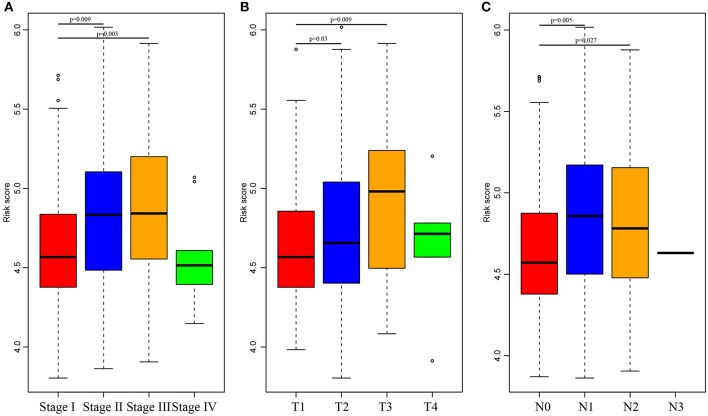
Comparison of RiskScore among different stages, invasion degree, and lymph node metastasis degree. The horizontal axis represents the different stages (A), invasion degree (B), and lymph node metastasis degree (C), and the vertical axis represents RiskScores.